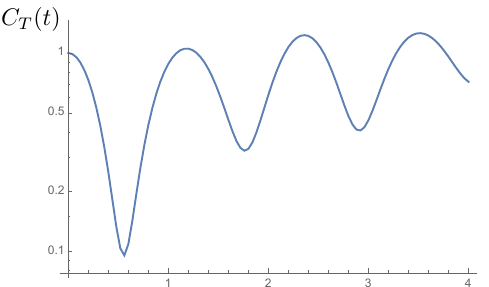
Figure 11 . The time evolution of the thermal OTOC C T ( t ) of the system (4.5), with the optimized coupling g (4.10), at the temperature value T saturating (4.11). For the numerical calculation we chose λ = 2 . Obviously there is no exponential growth seen, and the minimal value of the temperature is too low to detect the local maximum